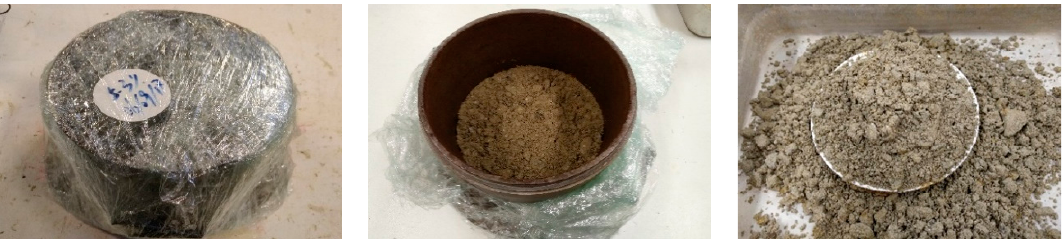
Figure 4. Filter paper method to measure matric suction.